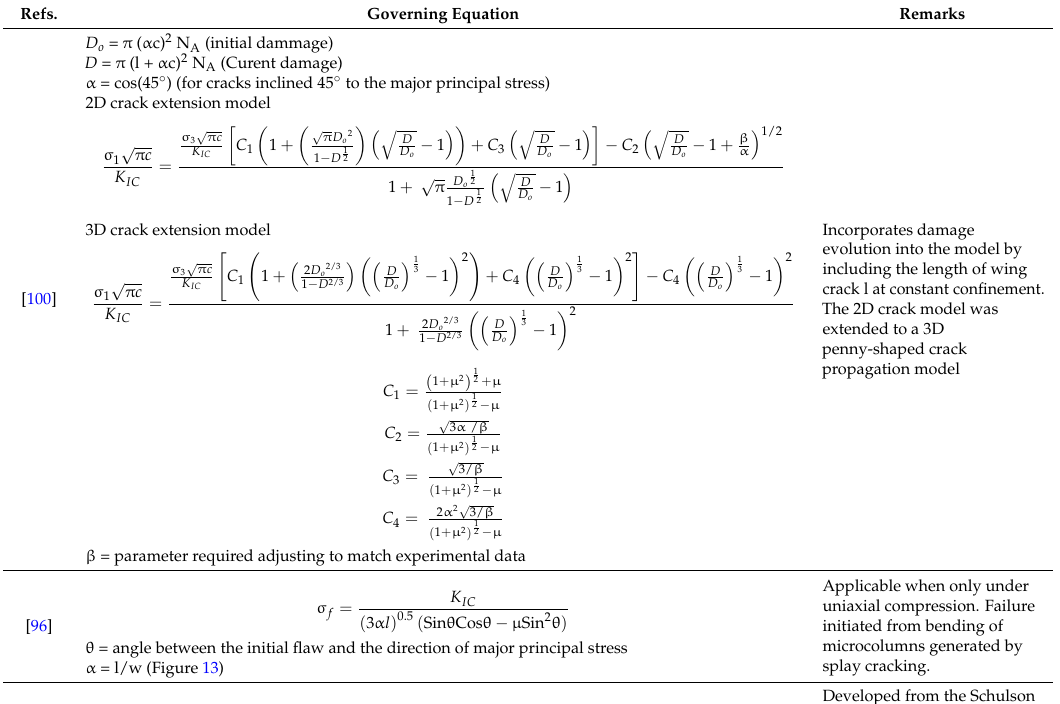
β = parameter required adjusting to match experimental data